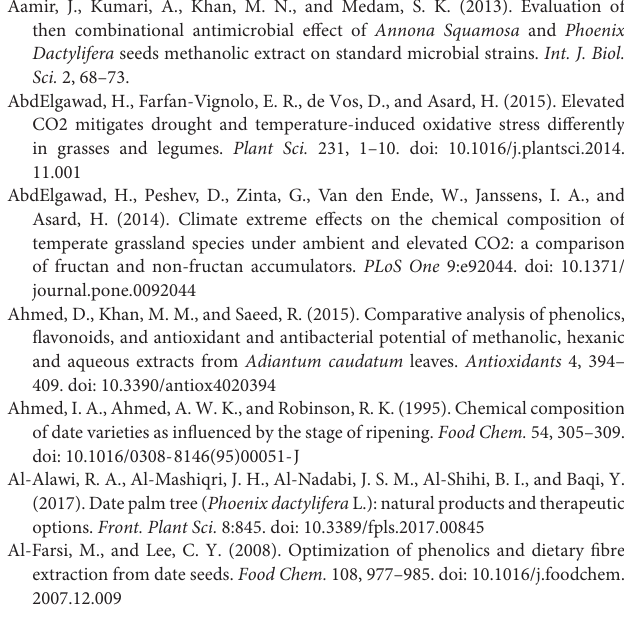
FIGURE S1 | Effect of different concentrations of β - D -glucogallin, 0 (control, (cid:7) ), 100 µ g/ml ( (cid:4) ), 200 µ g/ml ( (cid:78) ) on the viability of Staphylococcus aureus . Values are the average of three individual replicates (means ± SD). Different letters represent significant differences between the treatments (Duncan test; P < 0.05 and n = 4). TABLE S1 | Sugar concentrations in vermicompost-fertilized and non-fertilized P. dactylifera cv. Ajwa, Hulwa, Ruthana, Sefri, and Luban fruits. Vermicompost fertilization was carried out at a rate of 10 Kg/tree and fruits were harvested at the tamar stage. Different letters represent significant differences between the treatments in each cultivar (Duncan test; P < 0.05 and n = 4). TABLE S2 | Amino acid concentrations in vermicompost-fertilized and non-fertilized P. dactylifera cv. Ajwa, Hulwa, Ruthana, Sefri, and Luban fruits. Vermicompost fertilization was carried out at a rate of 10 Kg/tree and fruits were harvested at the tamar stage. Different letters represent significant differences between the treatments in the cultivar (Duncan test; P < 0.05 and n = 4). TABLE S3 | Organic acid concentrations in vermicompost-fertilized and non-fertilized P. dactylifera cv. Ajwa, Hulwa, Ruthana, Sefri, and Luban fruits. Vermicompost fertilization was carried out at a rate of 10 Kg/tree and fruits were harvested at the tamar stage. (a) Heat map and cluster tree representation of the organic acids, (b) the measured metabolites. Different letters represent significant differences between the treatments in the cultivar (Duncan test; P < 0.05 and n = 4). TABLE S4 | Fatty acid concentrations in vermicompost-fertilized and non-fertilized P. dactylifera cv. Ajwa, Hulwa, Ruthana, Sefri, and Luban fruits. Vermicompost fertilization was carried out at a rate of 10 Kg/tree and fruits were harvested at the tamar stage. Different letters represent significant differences between the treatments in the cultivar (Duncan test; P < 0.05 and n = 4). TABLE S5 | Mineral concentrations in vermicompost-fertilized and non-fertilized P. dactylifera cv. Ajwa, Hulwa, Ruthana, Sefri, and Luban fruits. Vermicompost fertilization was carried out at a rate of 10 Kg/tree and fruits were harvested at the tamar stage. Different letters represent significant differences between the treatments in the cultivar (Duncan test; P < 0.05 and n = 4). TABLE S6 | Vitamin concentrations in vermicompost-fertilized and non-fertilized P. dactylifera cv. Ajwa, Hulwa, Ruthana, Sefri, and Luban fruits. Vermicompost fertilization was carried out at a rate of 10 Kg/tree and fruits